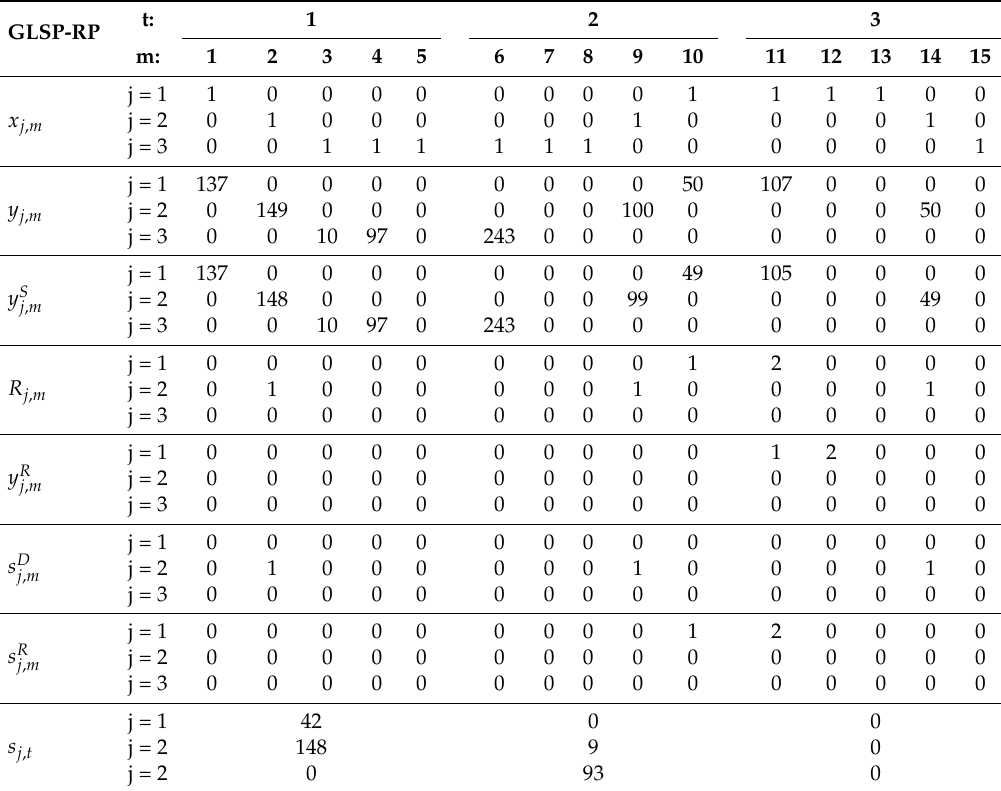
Table 4. Fixed GLSP-RP CPLEX